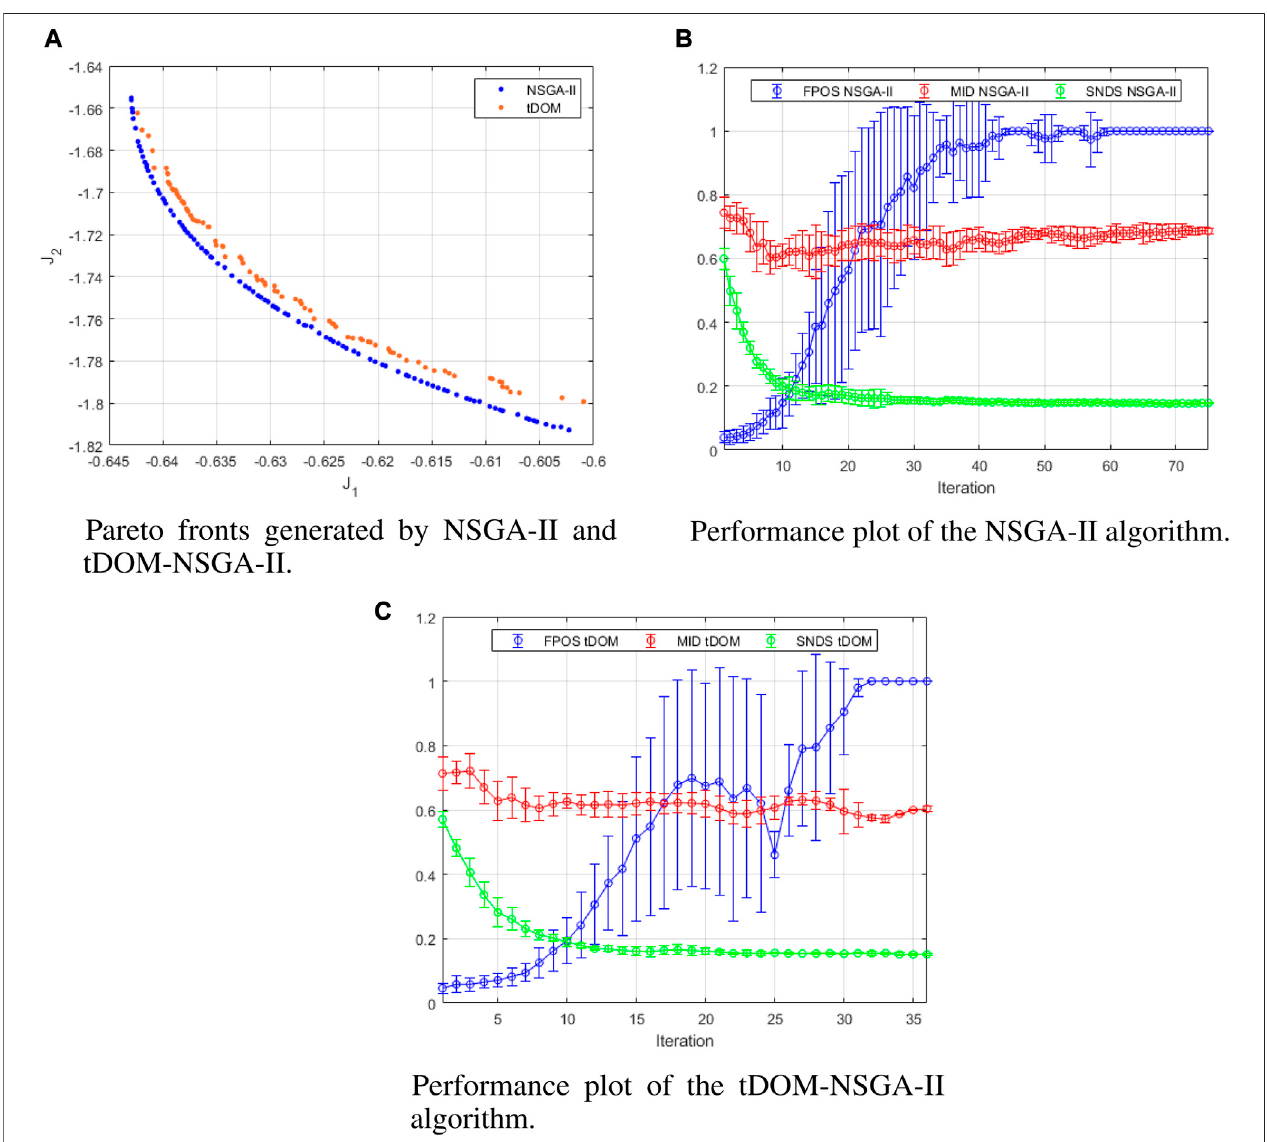
FIGURE 10 | Paretofrontsofthe Williams-Ottoreactor casestudygenerated by NSGA-II and tDOM-NSGA-II (A) , and their respectiveperformance plots (B) and (C) .